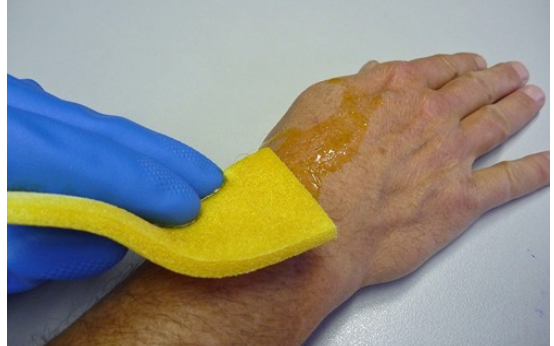
Figure 3. Skin decontamination by RSDL